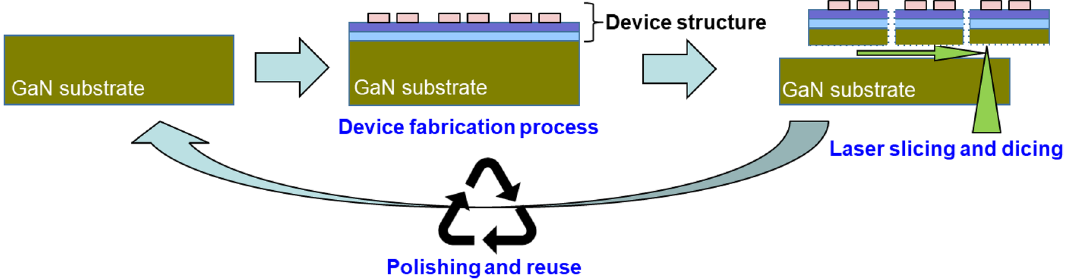
Figure 1. Schematic of device fabrication process with reusable